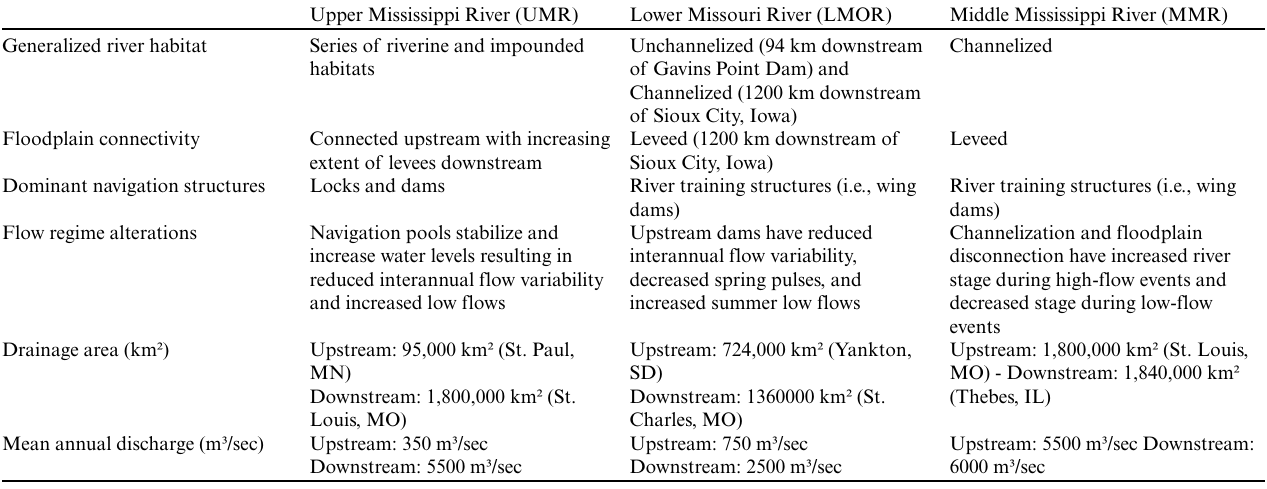
Table 1 . Defining attributes of the river-floodplain dynamics of the three study reaches.